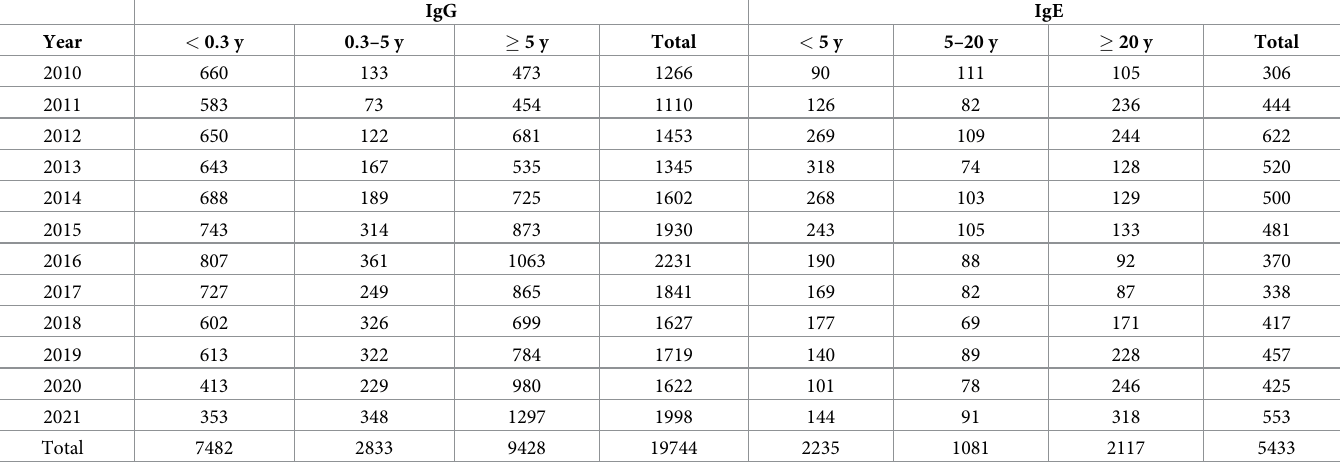
Table 1. Numbers of individuals for whom total nonspecific IgG or IgE were measured between 2010 and 2021.